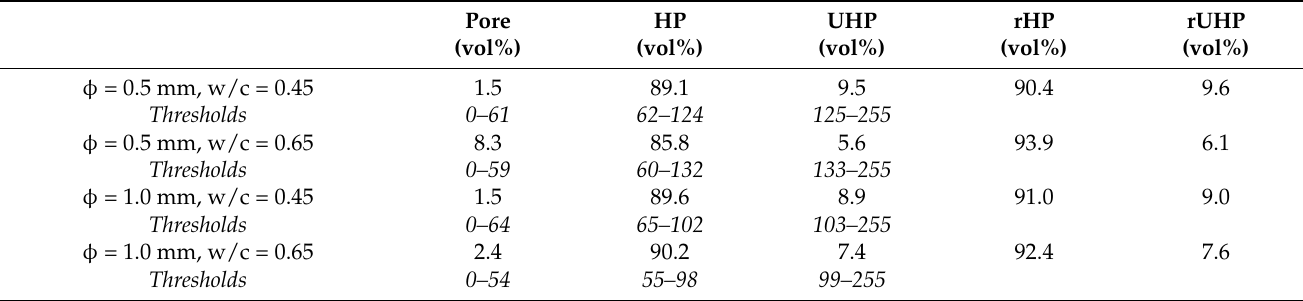
Figure 6. Volume of interest grey-scale histograms for ( a ) pastes within capillaries of ϕ = 0.5 mm with w/c = 0.45 and w/c = 0.65; ( b ) pastes within capillaries of ϕ = 1.0 mm with w/c = 0.45 and w/c = 0.65. The tangent-slope approach has been employed for estimating the threshold values between two components in the absence of valleys. Table 3. Segmentation results for the three sets of components (vol%) in the four analysed tomograms. The grey-scale ranges used for global segmentation are given in